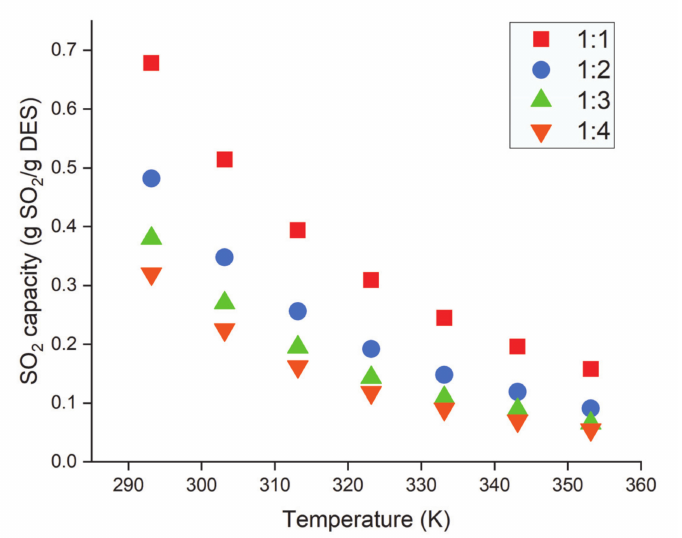
Figure 7. Effect of temperature and molar ratio on SO 2 capture capacity by ChCl/gly. Data are extracted from